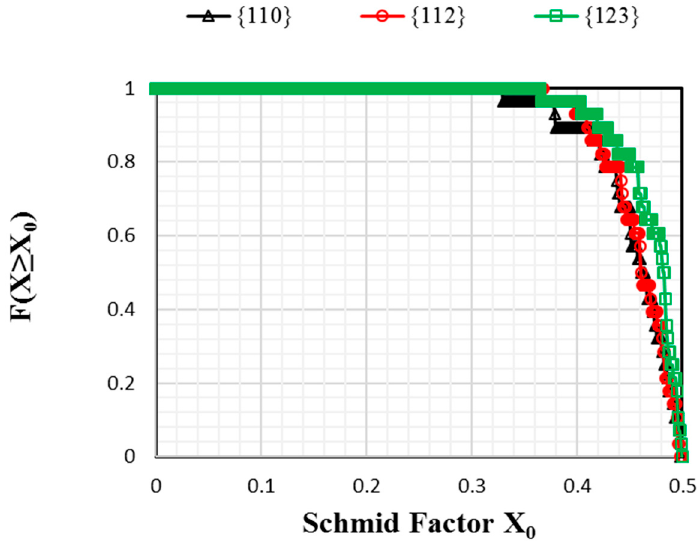
Figure 7. Cumulative distributions F( X (cid:3410) X (cid:2868) ) of maximum Schmid factors in grains distributed with an isotropic texture. The representation of the distributions is chosen in such a way that the ordinate of a point X (cid:2868) gives the fraction of grains with the Schmid factor X (cid:2868) or